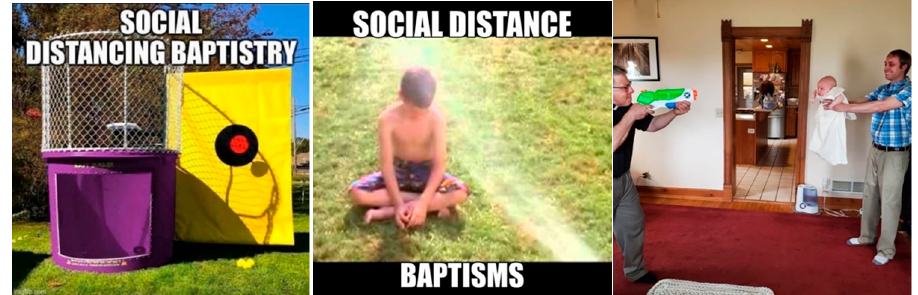
Figure 1. Examples of memes that present how the ritual of baptism has been playfully reimagined due to social distancing.